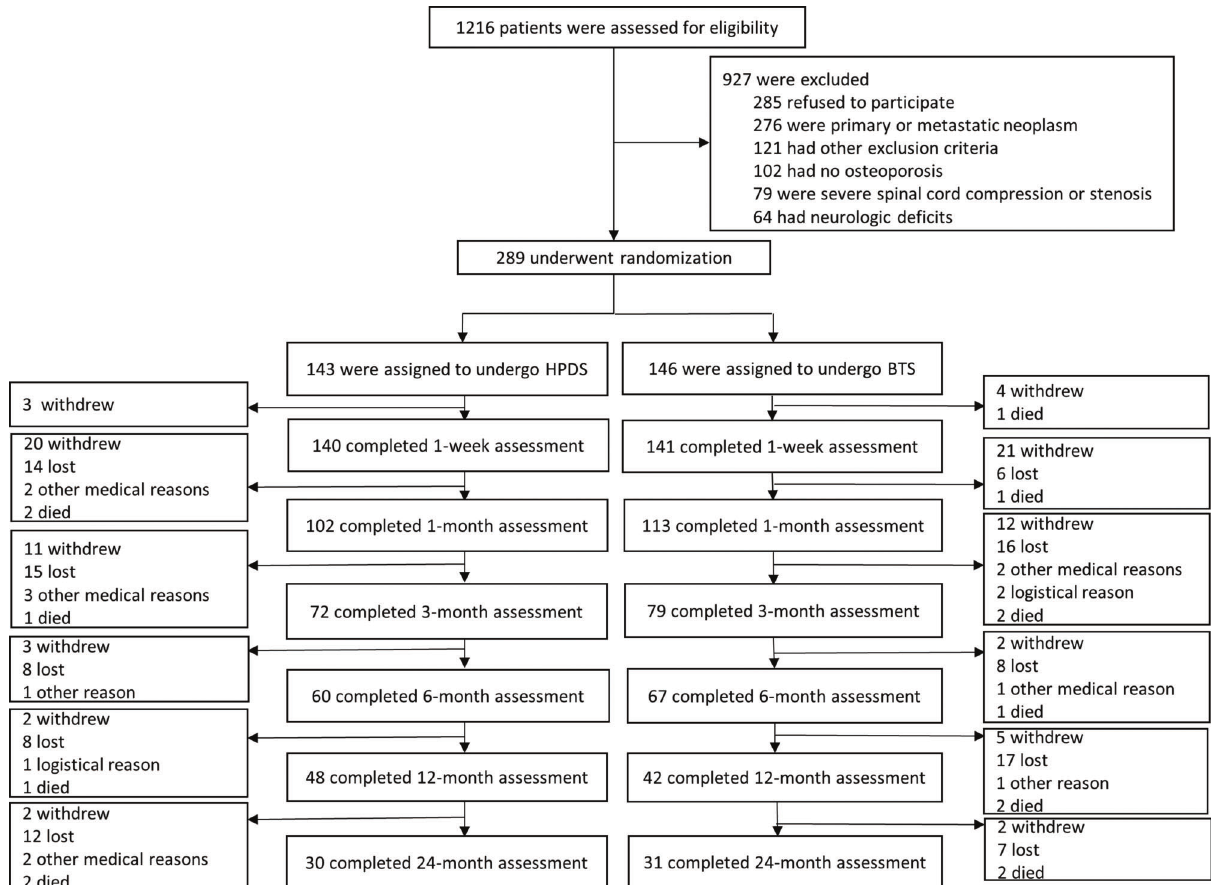
Figure 2 - Participant enrollment, assigned Intervention, and